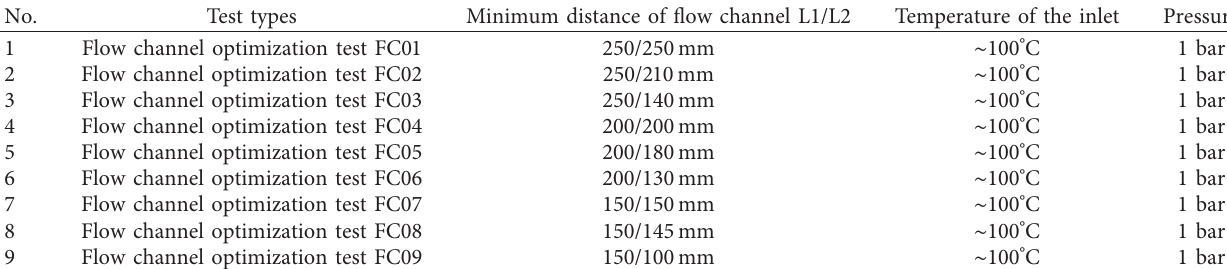
Table 3: Test conditions for the flow channel